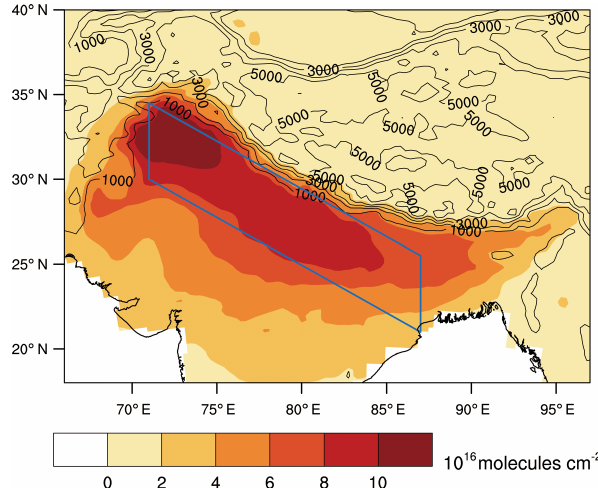
Figure 5. Spatial distributions of WRF-Chem-predicted total columns of NH 3 from June to August 2010 in the homogeneous emissions